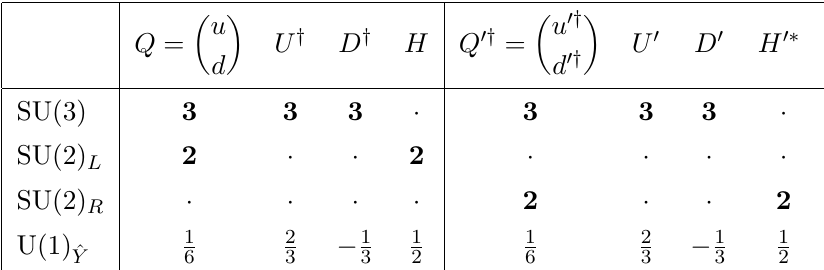
Table 1 . Quantum numbers in the quark and Higgs sectors. Mirror sector fields are distinguished with a prime. We use notation such that all of Q , U , and D (as well as their mirror counterparts Q 0 , U 0 , and D 0 ) are left-handed, two-component Weyl fermions, whereas daggered fields are always